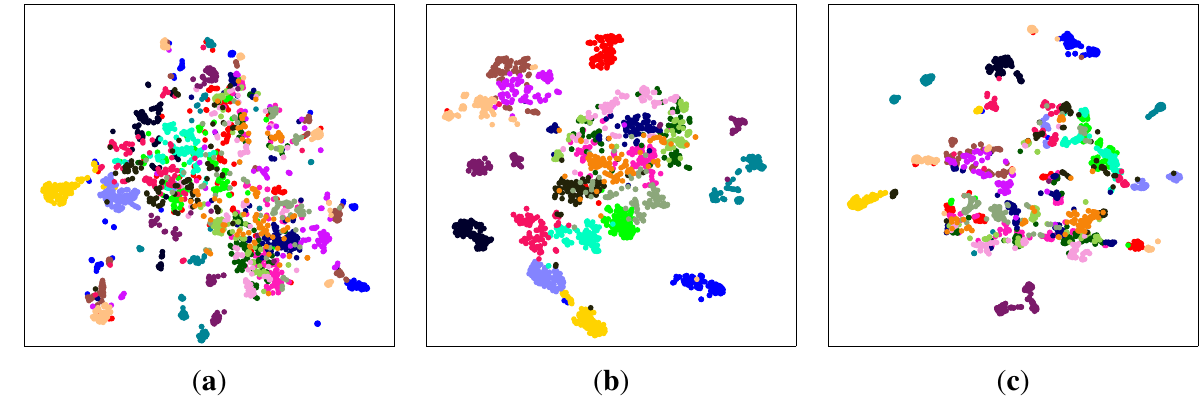
Figure 12. 2-D feature visualization of image global representations of the UCM dataset. The t-SNE proposed in [59] is used to visualize the high-dimensional image representations. The image representations are generated from ( a ) IFK with SIFT features; ( b ) features of the first FC layer; and ( c ) IFK with dense features from the last convolutional layer. The VGG-M model is used for ( b ) and ( c ). Each point on the graphs represents the 2-D feature of an image in the dataset. Each color represents a different category in the dataset. ( a ) IFK with SIFT features; ( b ) FC features of VGG-M; ( c ) IFK with dense CNN features of